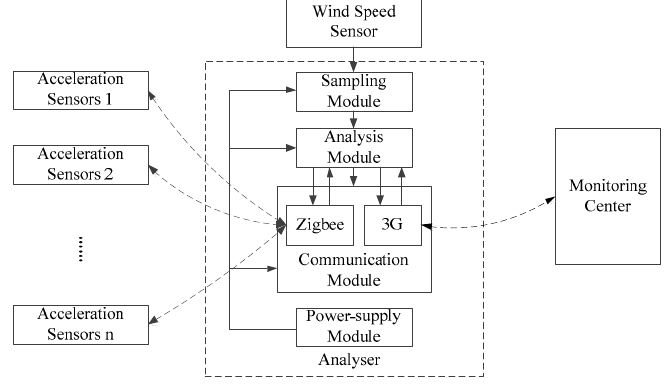
Figure 1. Block diagram of the system.